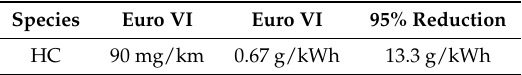
Table A2. HC Emission legislation.